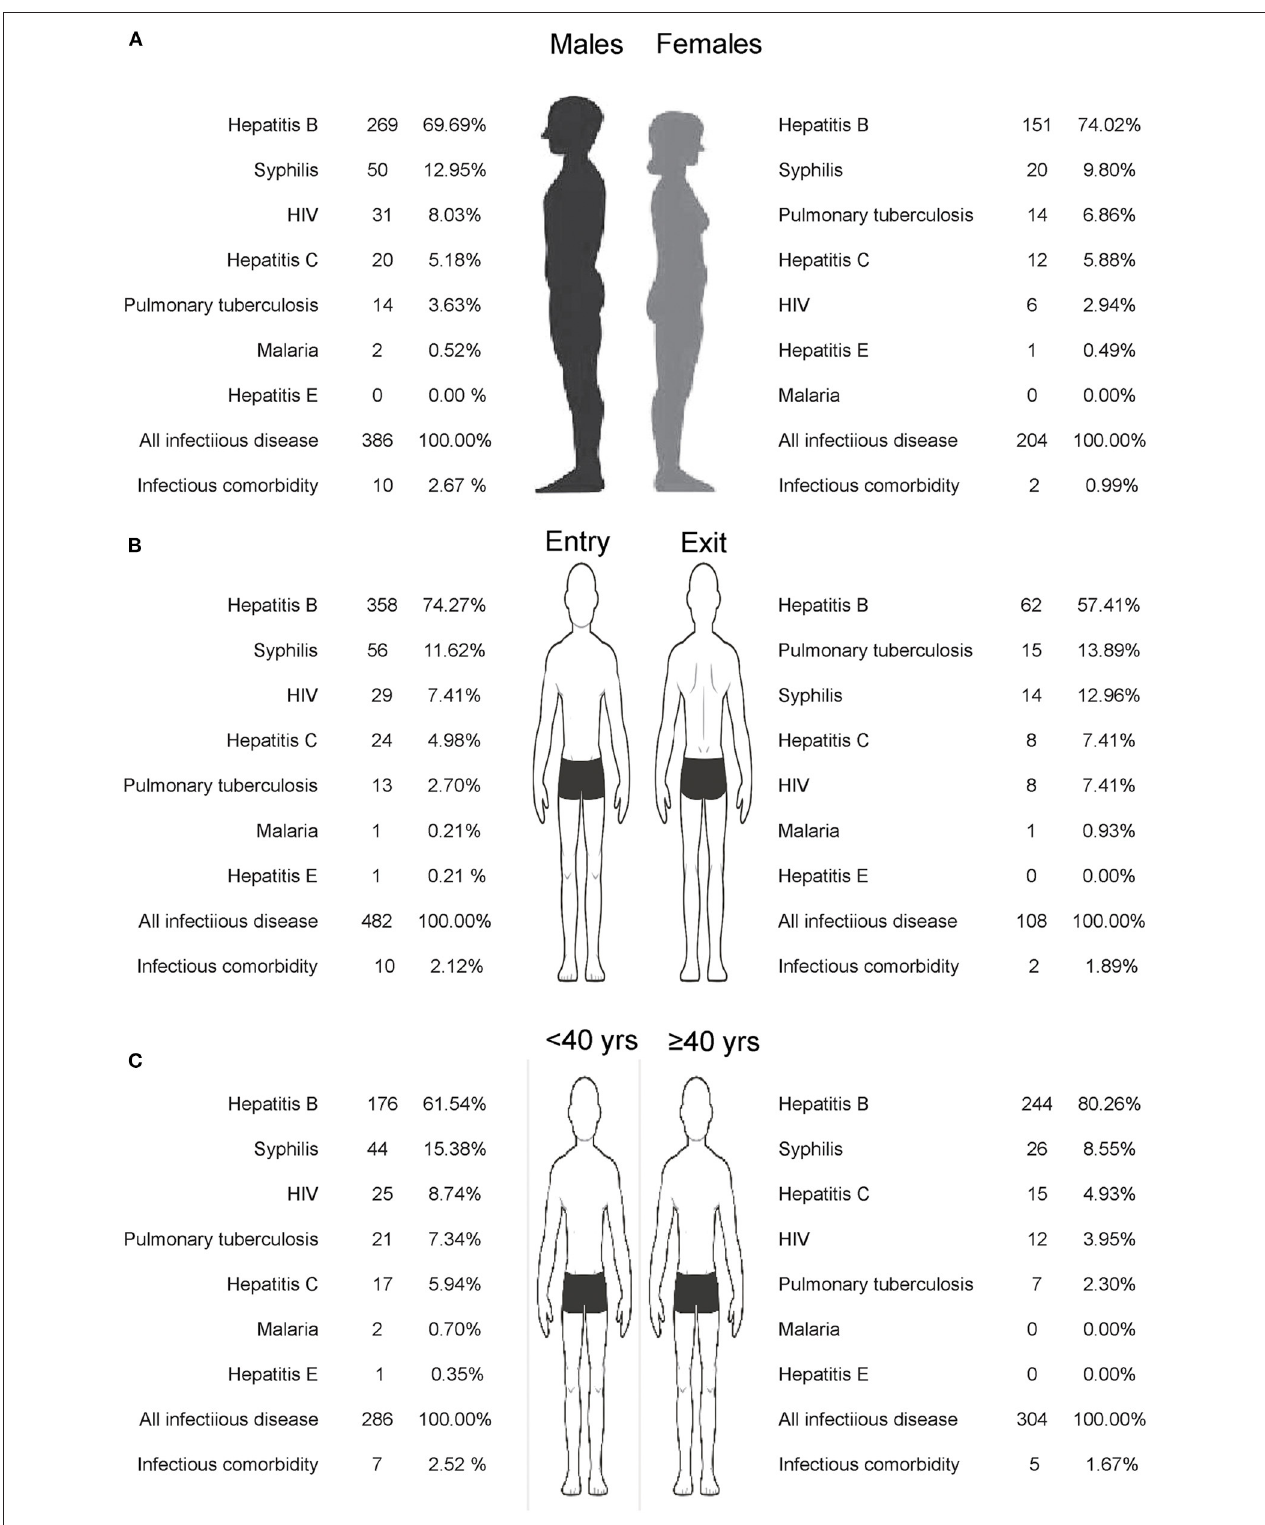
FIGURE 2 | Detection spectrum of infectious diseases of travelers at Shanghai Port, China, Jan 2019–Apr 2020 (A) Sex; (B) Entry and exit population; (C) Age group.